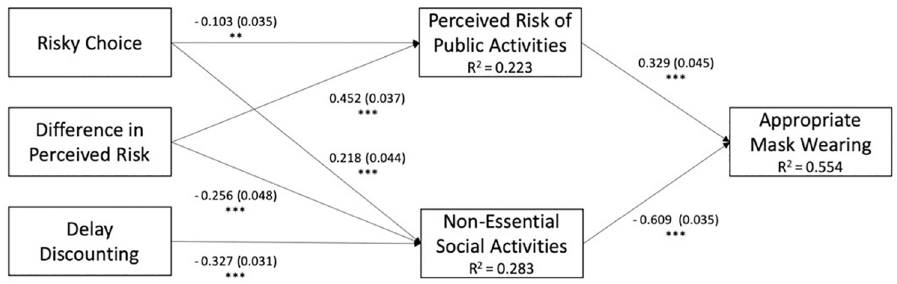
Fig 4. Path model showing the relationship between risky choice, delay discounting, and appropriate mask wearing behavior. Risky Choice indicates the overall proportion of risky decisions in the Risky Choice Task. The relationship between Delay Discounting scores and appropriate mask-wearing behavior was mediated by the frequency of engaging in non-essential social activities. The relationship between Risky Choice and appropriate mask- wearing behavior was mediated by both the frequency of engaging in non-essential social activities and one’s perceived risk of engaging in public activities. Values in parentheses indicate standard error. �� indicates p < .05. ��� indicates p <